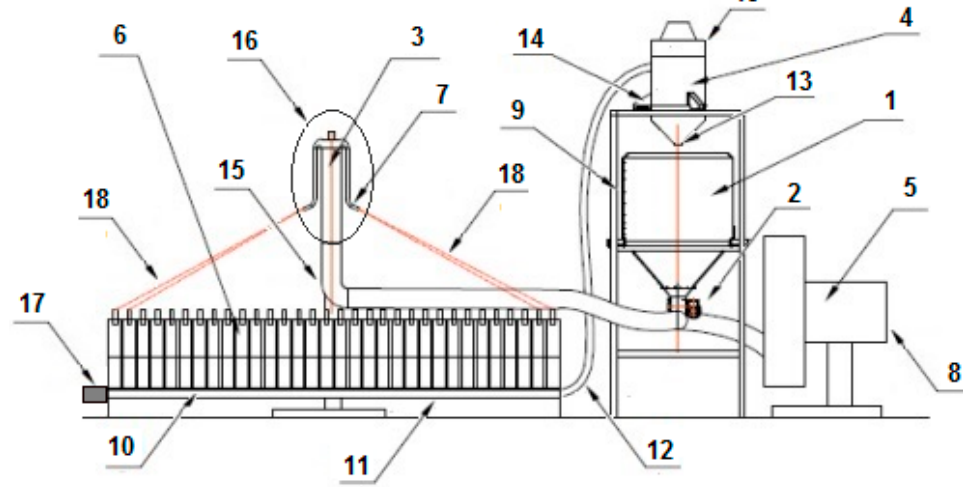
Figure 5. Diagram of the laboratory facility: 1—main tank, 2—sowing unit, 3—distribution head, 4—